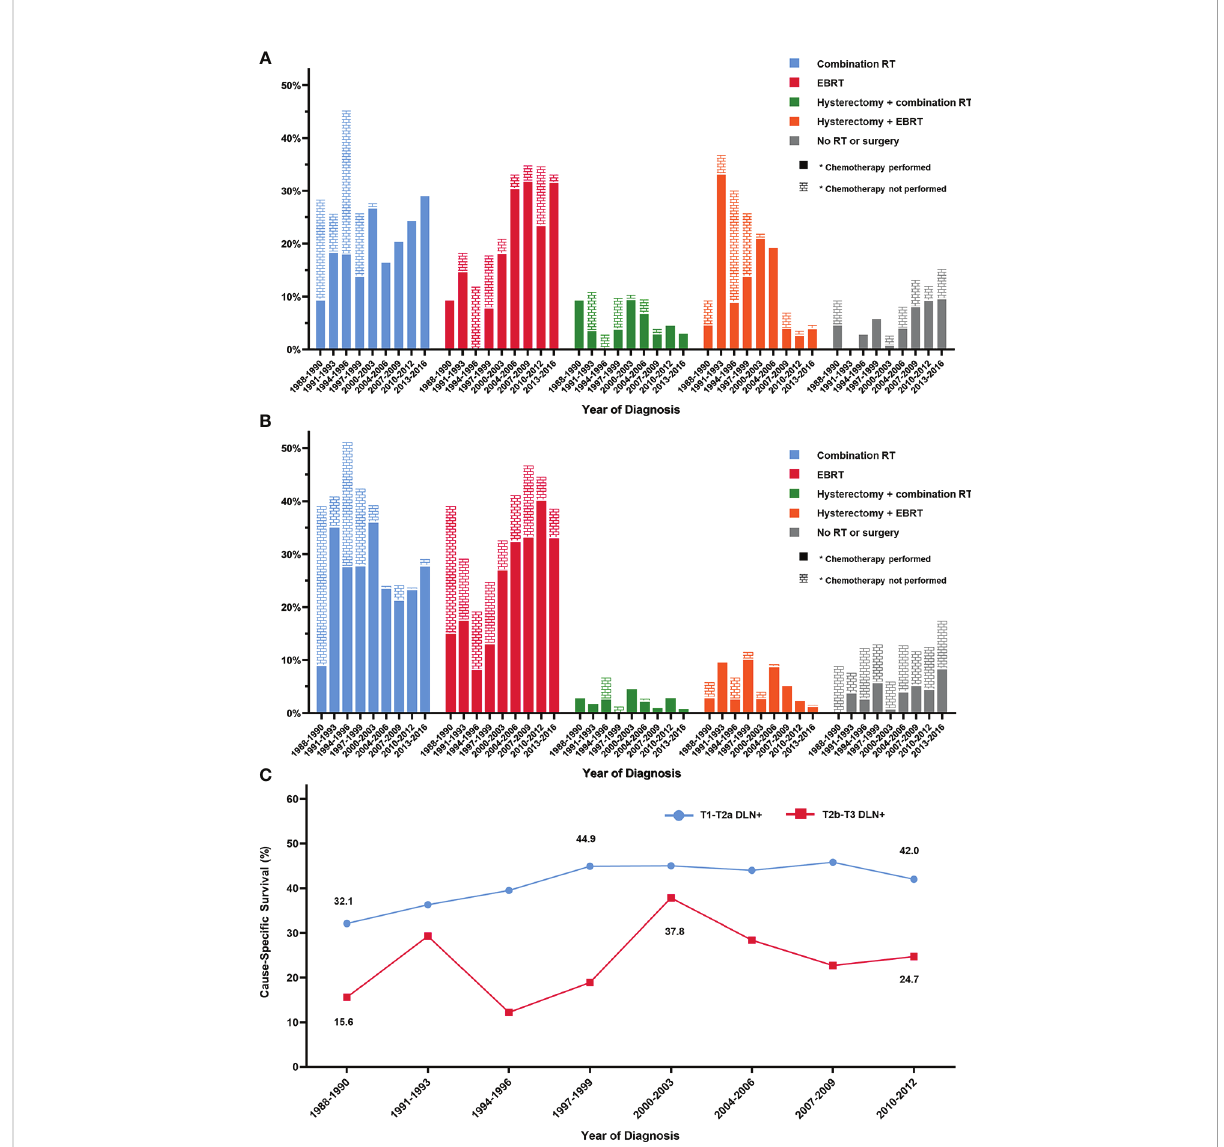
FIGURE 1 Changes of treatment pattern and survival for patients with distant lymph node metastasis. Treatment pattern for (A) patients with T1-T2a and distant lymph node metastasis, (B) patients with T2b-T3 and distant lymph node metastasis. (C) Changes of the 5-year cause-speci fi c survival. EBRT, external beam radiotherapy; DLN+, positive distant lymph nodes; RT,